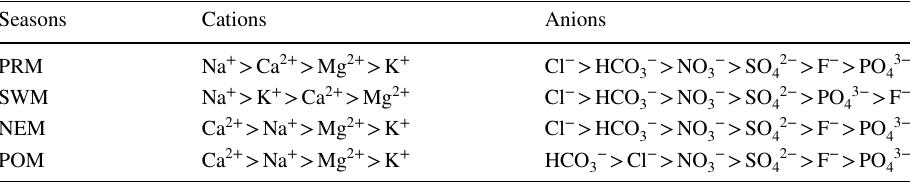
Table 5 The order of dominance of cations and anions in different